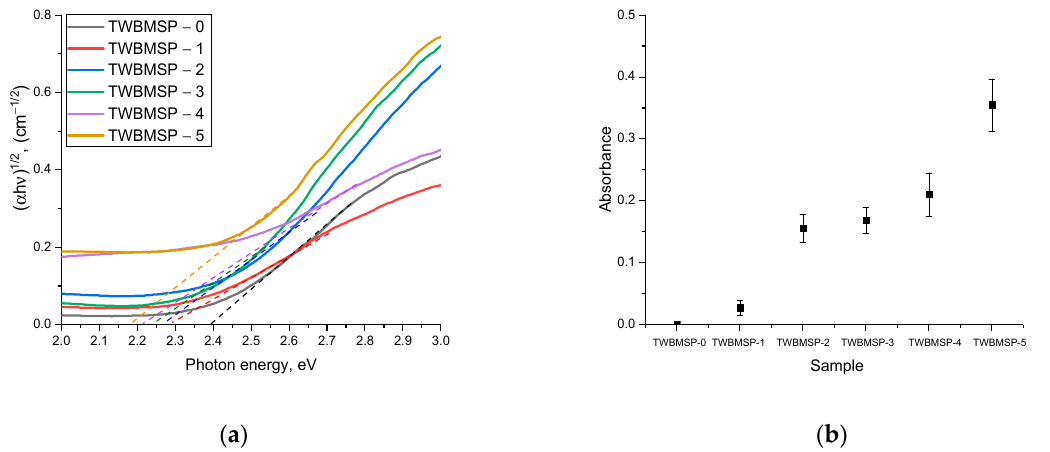
Figure 7. Results of the optical properties of samples under study: ( a ) Tauc’ plots; ( b ) Optical density results.